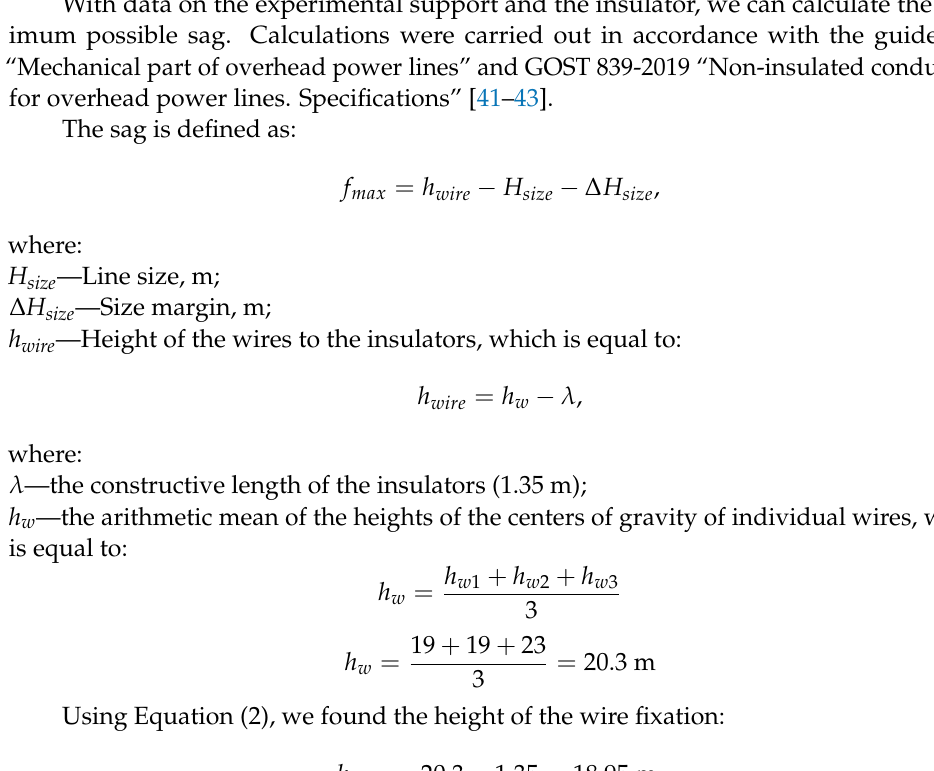
Table 8. Geometric dimensions of the line. Parameter Value Height of insulators, m 1.35 Height of the suspension of insulators of the wire 1 of the phase A circuit ( h w 1 ), m 19 Height of the suspension of insulators of the wire 1 of the phase B circuit ( h w 2 ), m 19 Height of the suspension of insulators of the wire 1 of the phase C circuit ( h w 3 ), m